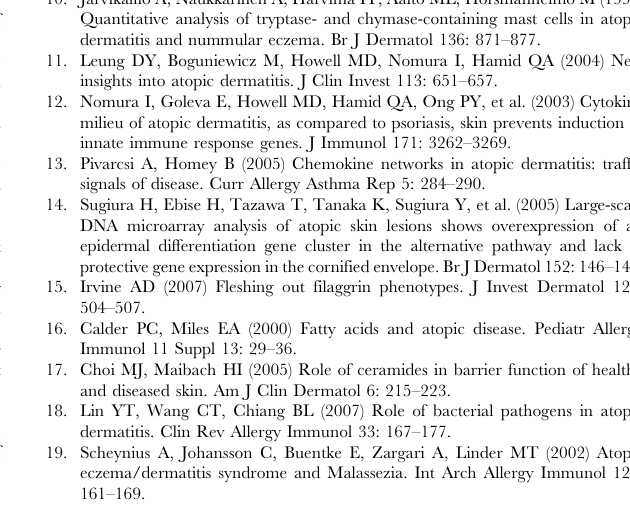
Table S1 Genes differentially expressed between skin from AE patients and healthy control individuals. Shown are a detailed list of , 4,000 genes identified by the multi-group SAM approach to be consistently differentially expressed between AE and healthy skin (FDR , 0.003). This set of genes is the same genes that are shown in Figure 1.